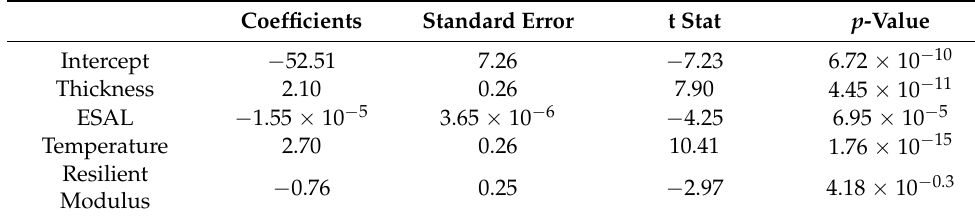
Table 2. Hypothesis testing values for input variables.